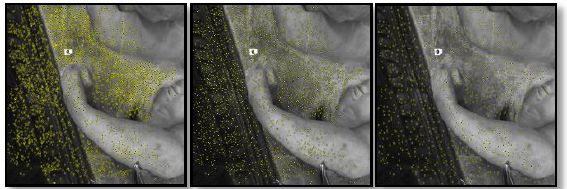
Figure 2. Point distribution in the image space before and after filtering (3395, 2007 and 819 points according to a filtering distance of 0, 20 and 40